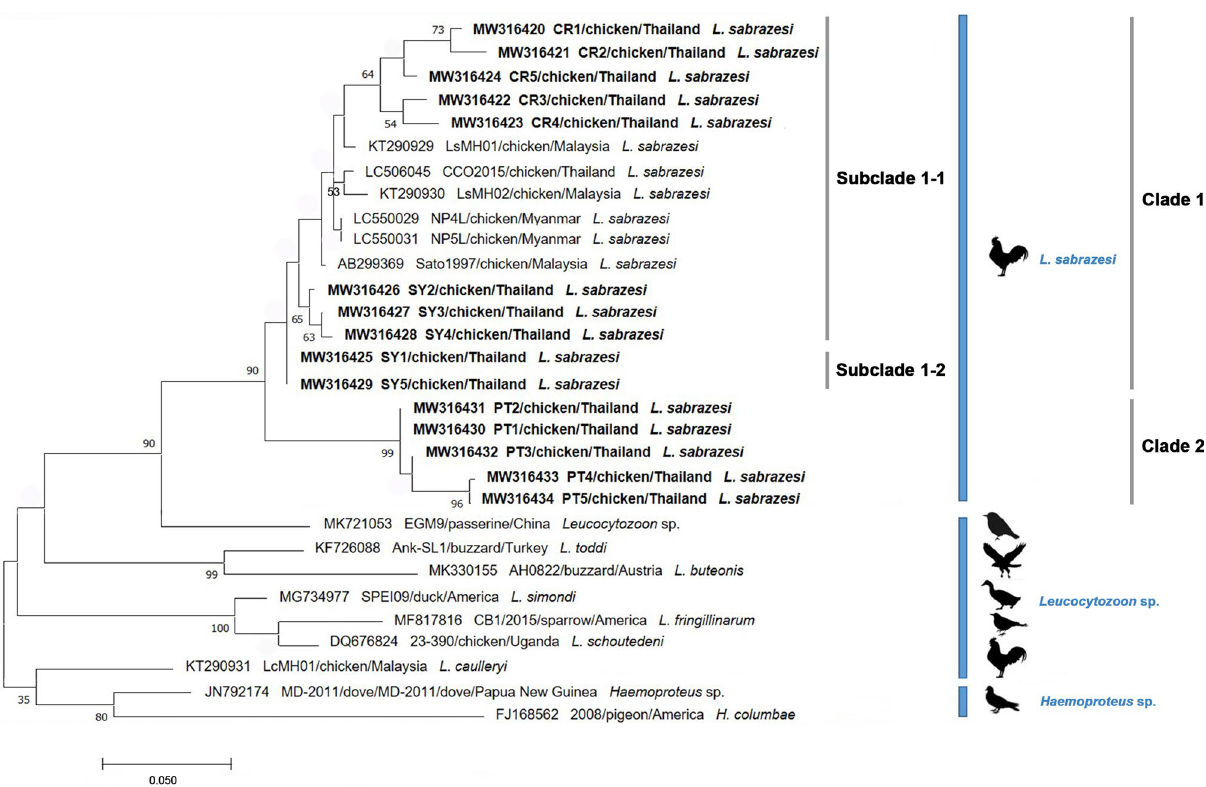
Figure 2. A Maximum Likelihood (ML) phylogenetic tree of L. sabrazesi cytb gene sequences in this study (blodface) and those taken from GenBank. The numbers on each node correspond to the bootstrap analysis of 1000 replicates (percentage more than 50% were listed). The GenBank assession numbers, the country and the parasite species name of the sequences are exhibited. Two gene sequences of Haemoproteus sp. were employed as the outer groups. The scale bar exhibits the number of substitutions per site. Clade Clade 1